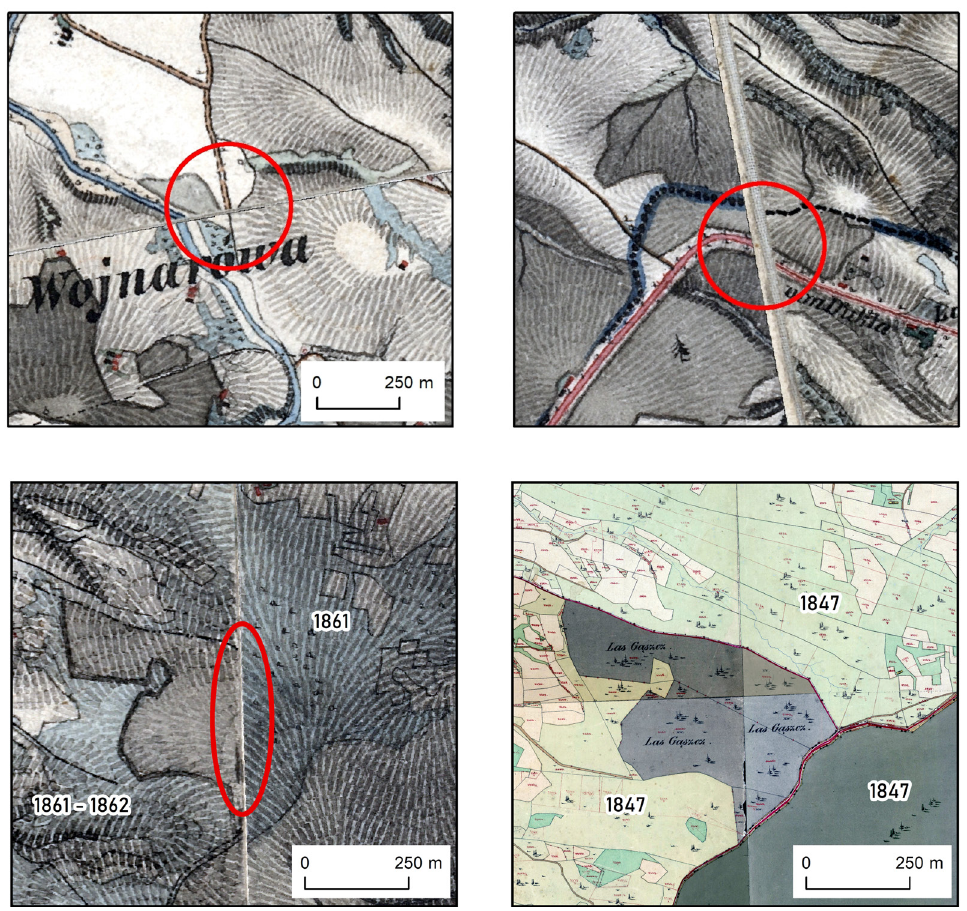
Fig. 2. Examples of content discrepancies at sheet boundaries. Top: change from the category of maintained road (ger. Erhaltener Fahrwegen ) to unmaintained (ger. Nicht Erhaltener Fahrwegen ) (left), and from first-class road (ger. Chaussée I. Klasse , Kaiserstrassen ) to second-class road (ger. Chaussée II. Klasse , Kaiserstrassen ) (right). Bottom: change of forest use to pastures (left). For comparison, the continuity of forest use at the junction of sections of the cadastral map 1:2,880